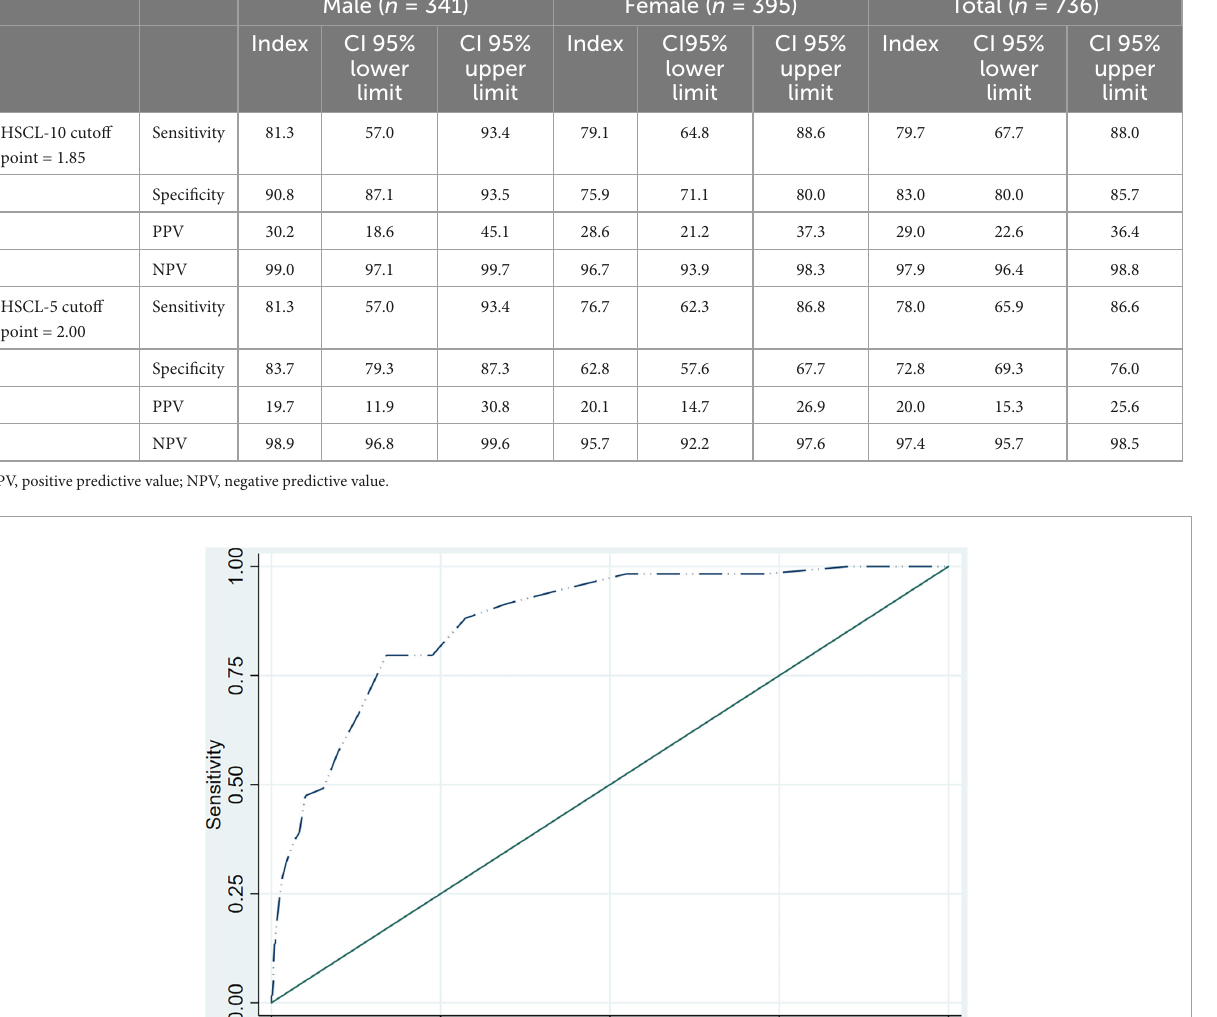
TABLE 6 Sensitivity, specificity, positive and negative predictive values, total and by gender in the HSCL-10, and the HSCL-5. HSCL-10 cutoff point = 1.85